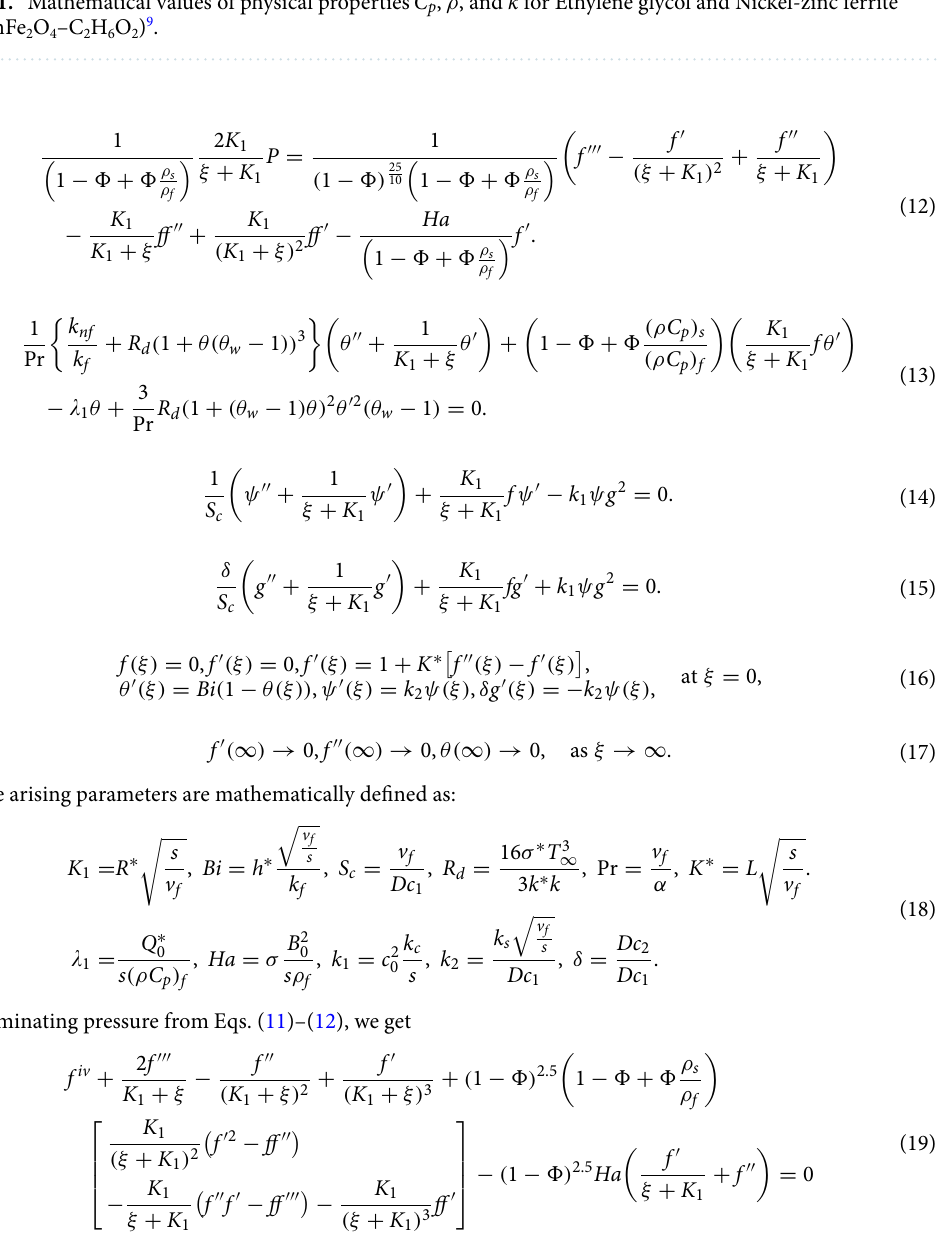
Table 1. Mathematical values of physical properties C p , ρ , and k for Ethylene glycol and Nickel-zinc